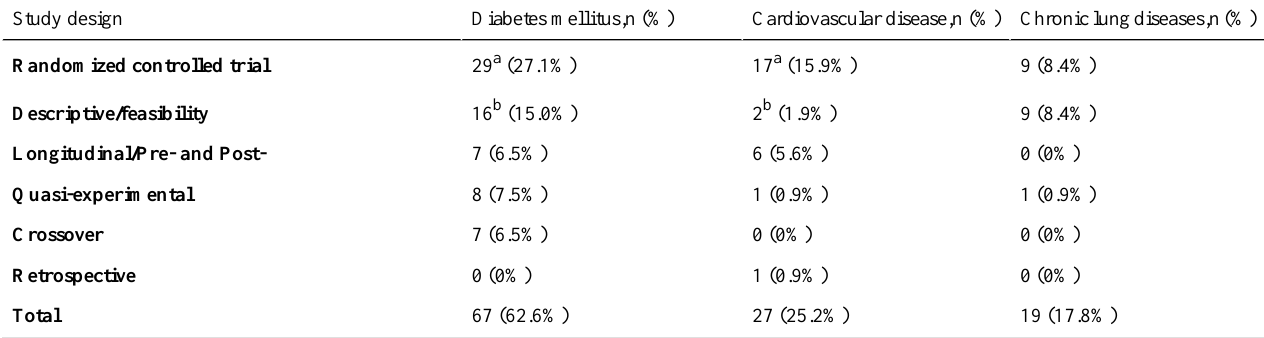
Table 1. Study designs by chronic disease